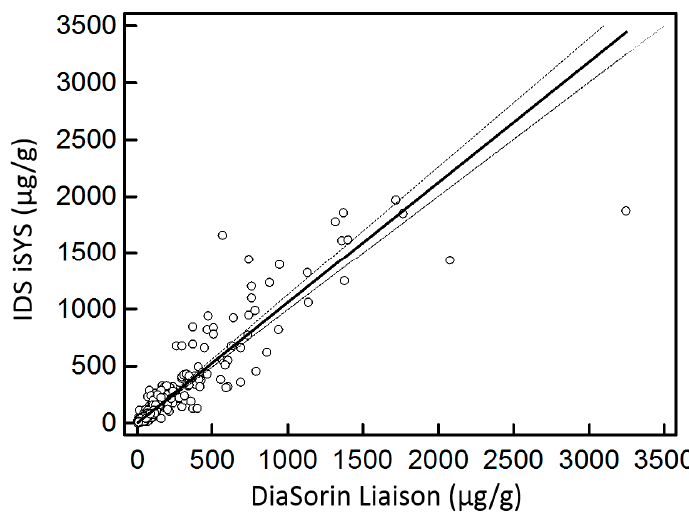
Figure 2. Passing and Bablok regression for FC measurement.